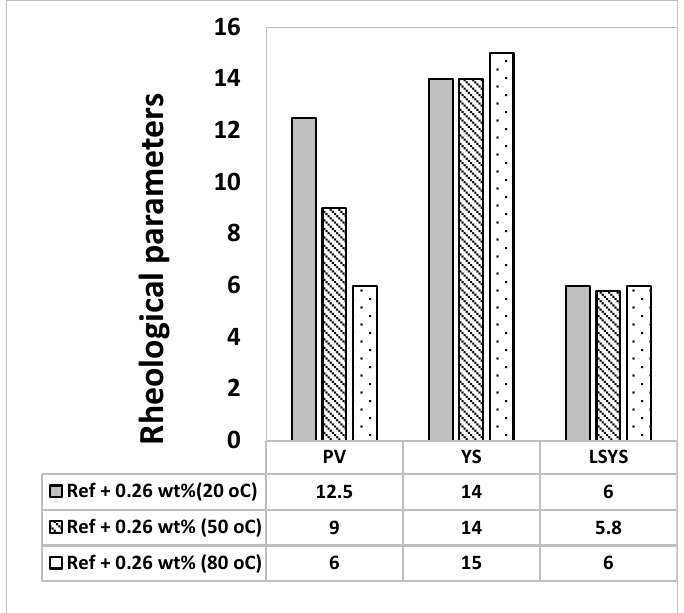
Figure 4. MoS 2 mixed drilling fluid — 0.19 wt.%.